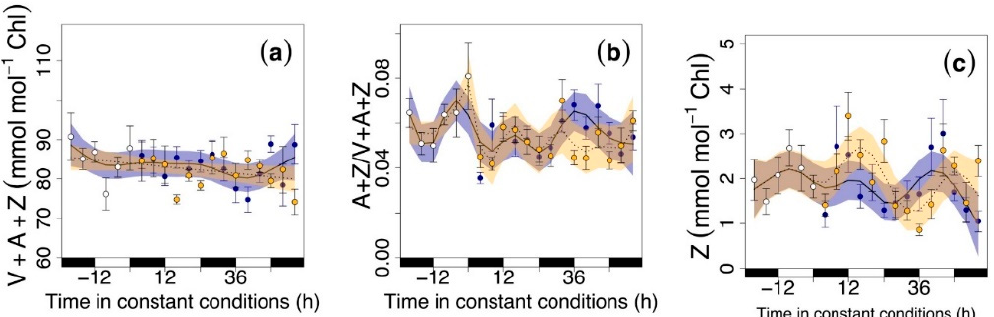
Figure 3. Xanthophylls in rocket leaves during the last cycle of the entrainment period (white circles) and under continuous dark (blue circles) and light conditions (yellow circles): ( a ) the total pool of xanthophyll cycle pigments expressed on a chlorophyll basis (V + A + Z; mmol mol − 1 Chl), ( b ) the de-epoxidation state (A + Z / V + A + Z), and ( c ) the total zeaxanthin are expressed on a chlorophyll basis (Z; mmol mol − 1 Chl). Black and white rectangles on the x -axis symbolize subjective night and day, respectively (that is, when leaves would have experienced nighttime or daytime conditions). Time zero indicates the time when constant conditions started. Temporal patterns were examined with the generalized additive model (GAM) fitted with an automated smoothness selection [31]. Shaded areas indicate the 95% CI of the fitted GAM. Values are the mean ± S.E ( n = 10).